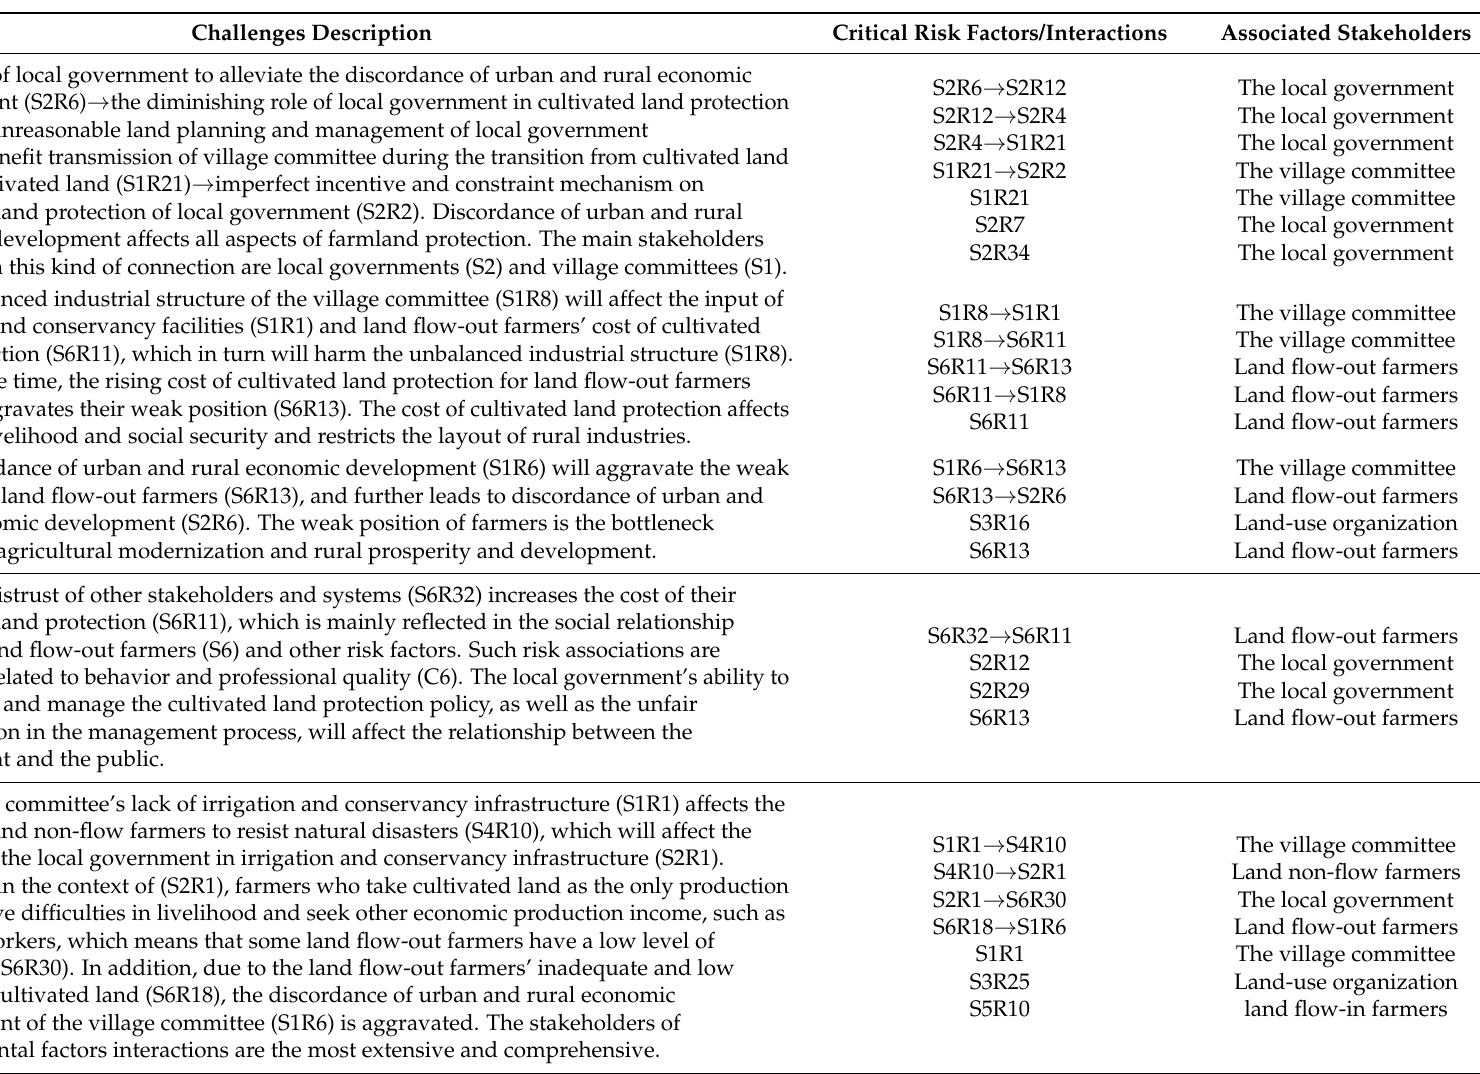
Table 4. Risk classification and